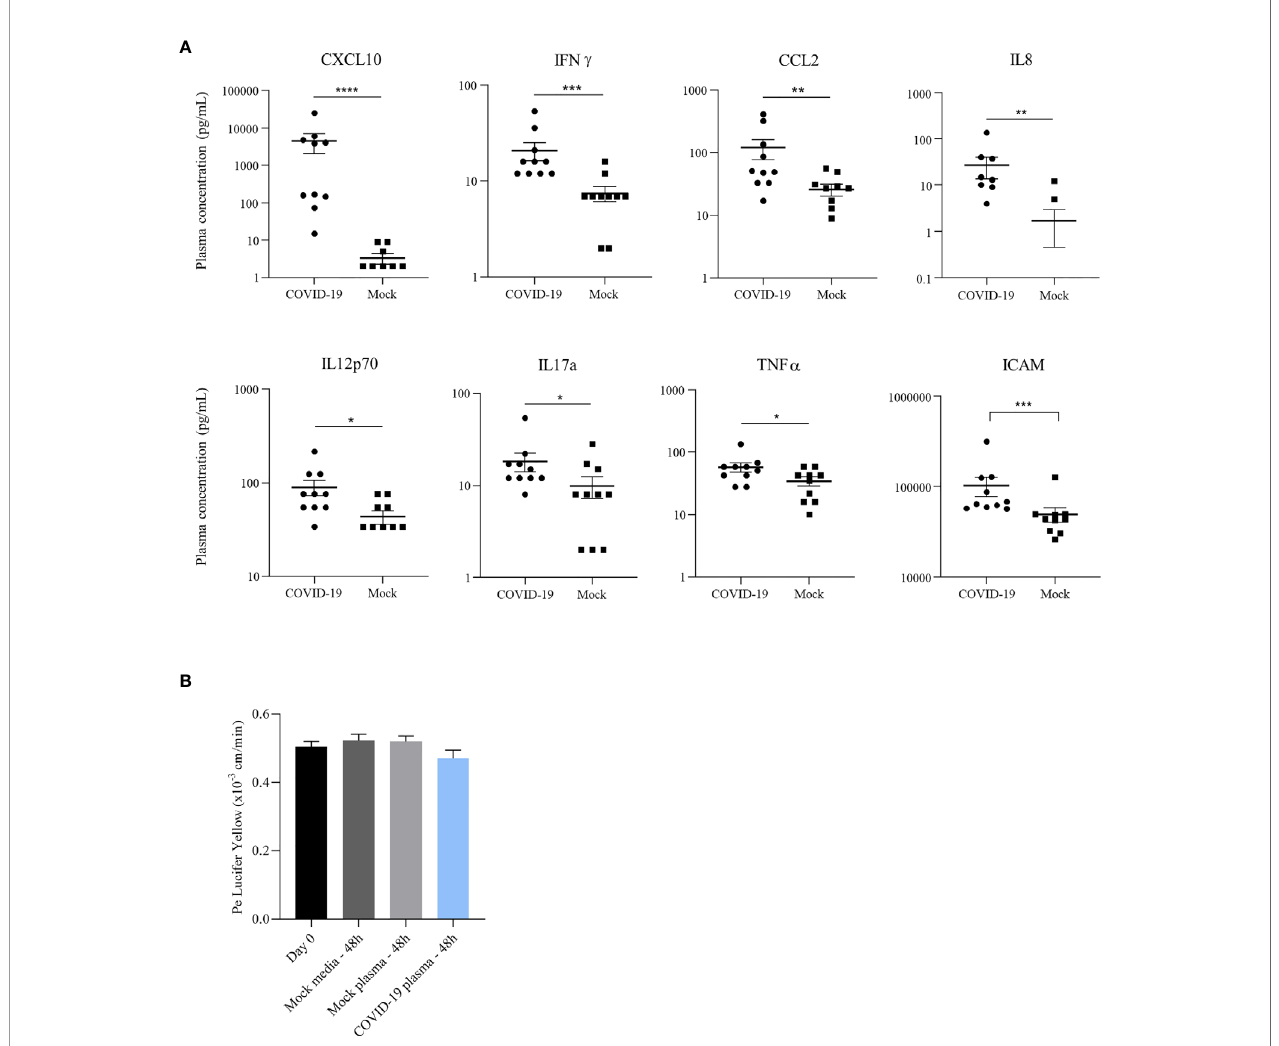
FIGURE 4 | COVID-19 patient plasma do not induce endothelium impairment or in fl ammatory response in a bi-cultured BBB model despite a pro-in fl ammatory environment. (A) Concentration (pg/mL) of different pro-in fl ammatory cytokines in plasma of COVID-19 patients hospitalized in Montpellier, France, and non-infected individuals quanti fi ed by a multiplex bead-based ELISA: in order, CXCL10, IFN- g , CCL2, IL-8, IL-12p70, IL-17a and TNF- a ; Analyses of soluble ICAM-1 concentration (pg/mL) in plasma from healthy and COVID-19 patients by ELISA assay. Bars show means ± SEM (n = 10; * p < 0.05 ** p < 0.01 *** p < 0.001 **** p < 0.0001). (B) Permeability coef fi cient of Lucifer Yellow at day of infection (day 0) and following 48 hours after incubation of hBLECs with different COVID-19 plasmas, healthy control plasma or media. Bars show mean of 3 independent experiments ±